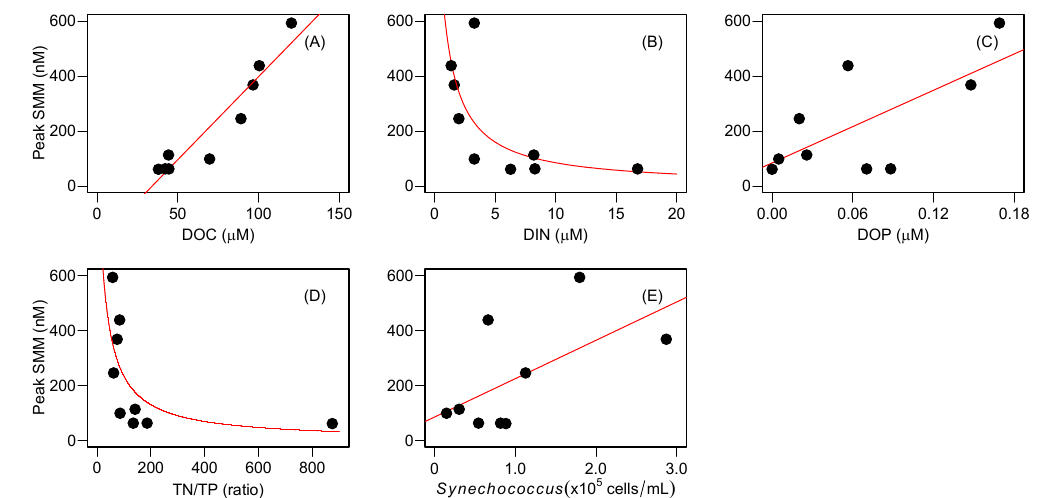
Figure 7. Relationships between lake environmental variables and the peak subsurface methane maximum (SMM) for the study lakes. For the relationships of both dissolved inorganic nitrogen (DIN) and TN / TP, the regression lines were estimated using generalized linear models (GLMs) with a gamma error distribution and an inverse link function for each variable, while the GLM with a Gaussian error distribution and an identity link function was used for the other variables. For explanatory variables, the values at the peak SMM depths were used for the